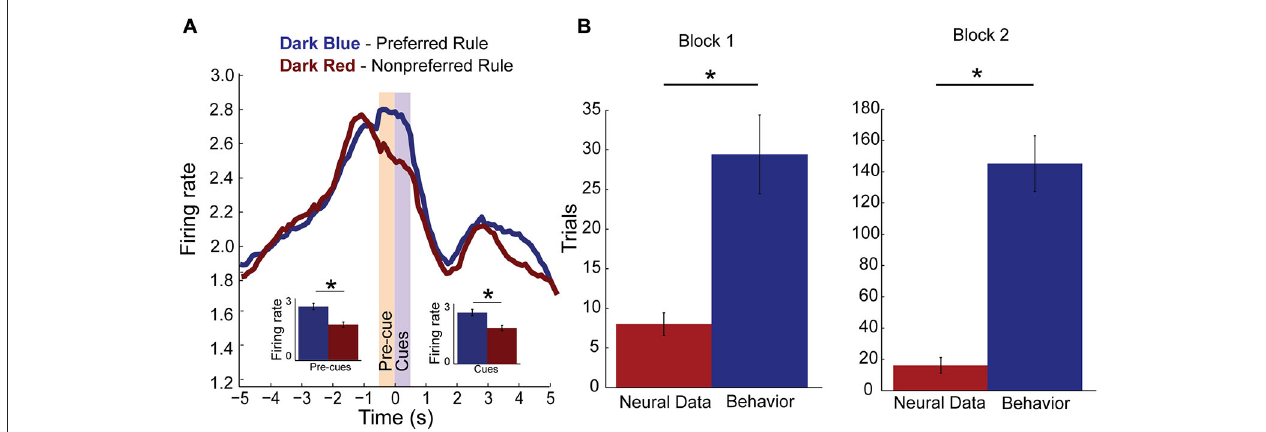
FIGURE 3 | Rule encoding in the medial Prefrontal Cortex (mPFC). (A) Population activity of rule neurons, plotted by preferred (dark blue) and non-preferred (dark red) rule blocks centered on cue presentation (time 0). Activity significantly divides during pre-cue epoch (yellow bar, − 500–0 ms, inset) and remains higher for one rule over another during the cue epoch (purple bar, 0–500 ms, inset). (B) Bar plots comparing when rule neurons first significantly modulate activity in preferred rule block (red bar) and when rats first reached behavioral criterion (blue bar). Change in rule neuron activity precedes behavioral criterion regardless of whether the neuron’s preferred rule was in block one or two. Significance of at least p < 0.05 denoted with asterisk ∗ .